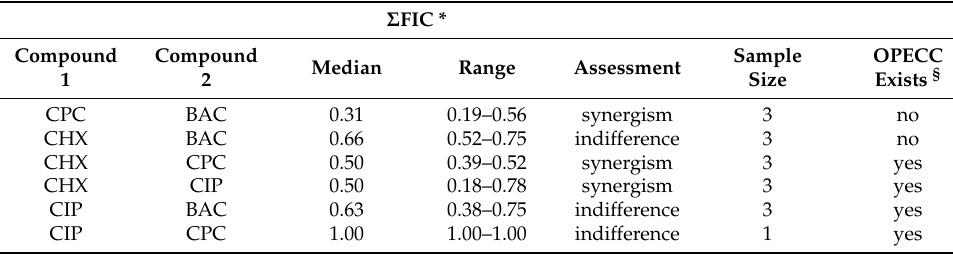
Table 4. Fractional inhibitory concentration ( Σ FIC) presented as median and range for binary combinations of the four tested